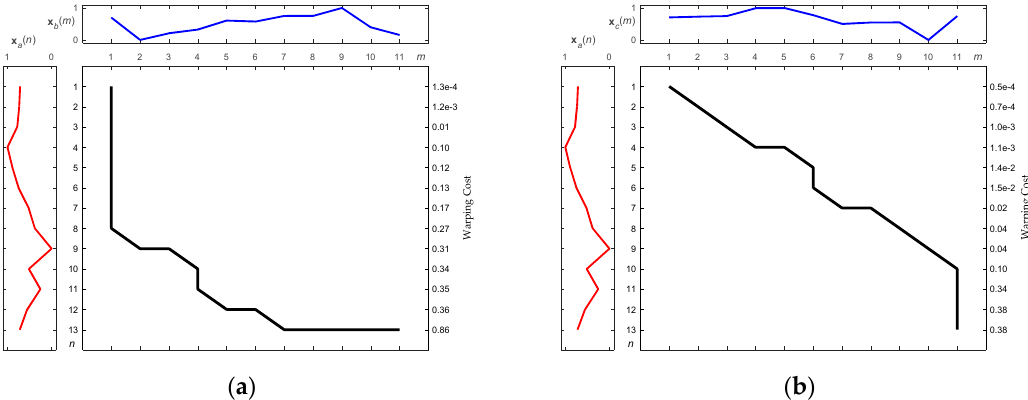
Figure 10. Optimal warping paths along with accumulated warping cost calculations corresponding to Figure 9. ( a ) Between x a and x b ; ( b ) Between x a and x c .